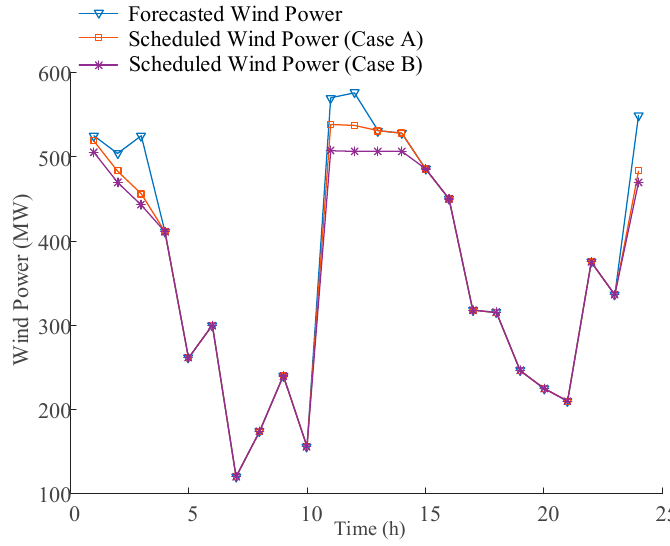
Figure 8. Scheduled power in day-ahead scheduling stage.